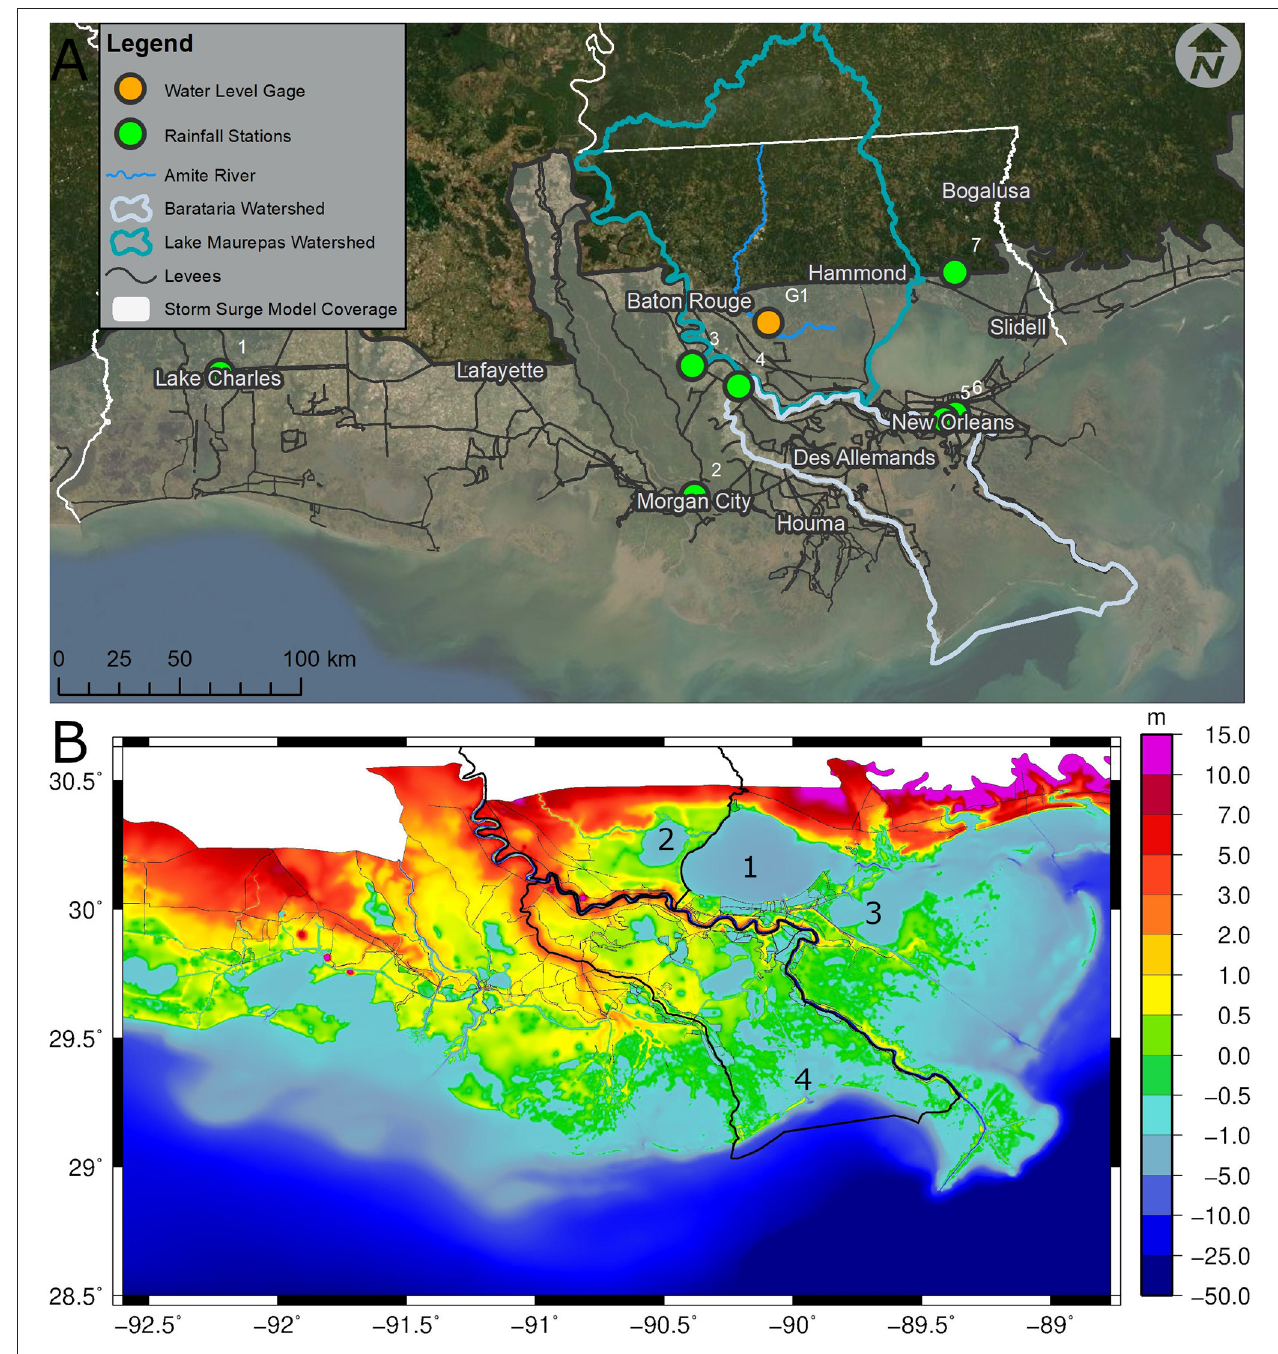
FIGURE 1 | (A) Overall region of study in southeastern Louisiana. The ADCIRC storm surge model boundary is shown as a transparent background that extends across the coastal floodplain in naturally dry regions. Barataria and Lake Maurepas Watersheds are enveloped by bold off-white and aqua lines. USGS gage 07380120 is shown in orange (G1). Rainfall stations are labeled as follows: (1) Lake Charles, (2) Morgan City, (3) Baton Rouge, (4) Donaldsonville, (5) New Orleans Audubon Park, (6) New Orleans International Airport, and (6) Abita Springs. Thin white lines delineate the state boundaries. Service Layer Credits: Source: Esri, Maxar, GeoEye, Earthstart Geographics, CNES/Airbus DS, USDA, USGS, AeroGRID, IGN, and the GIS User Community. (B) Topographic and bathymetric elevations (m, NAVD88) of the ADCIRC unstructured mesh of coastal Louisiana. The Lake Maurepas and Barataria watersheds are outlined in black. Label (1) is Lake Pontchartrain, (2) is Lake Maurepas, (3) is Lake Borgne, and (4) is Barataria Bay.